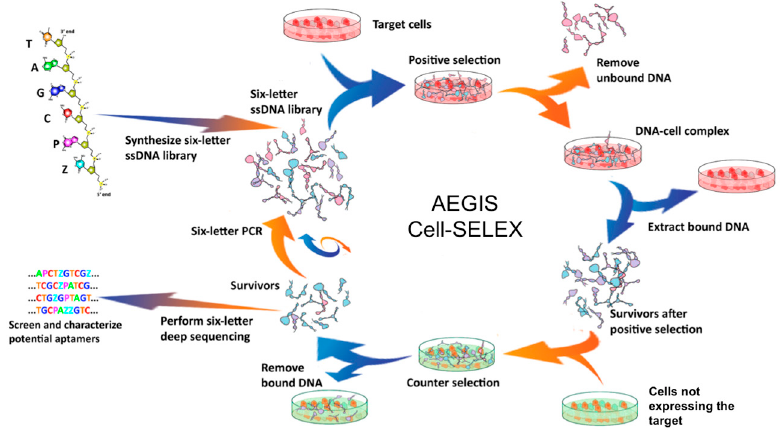
Figure 3. Schematic of AEGIS-Cell-SELEX (see text for details, adapted from [93]).